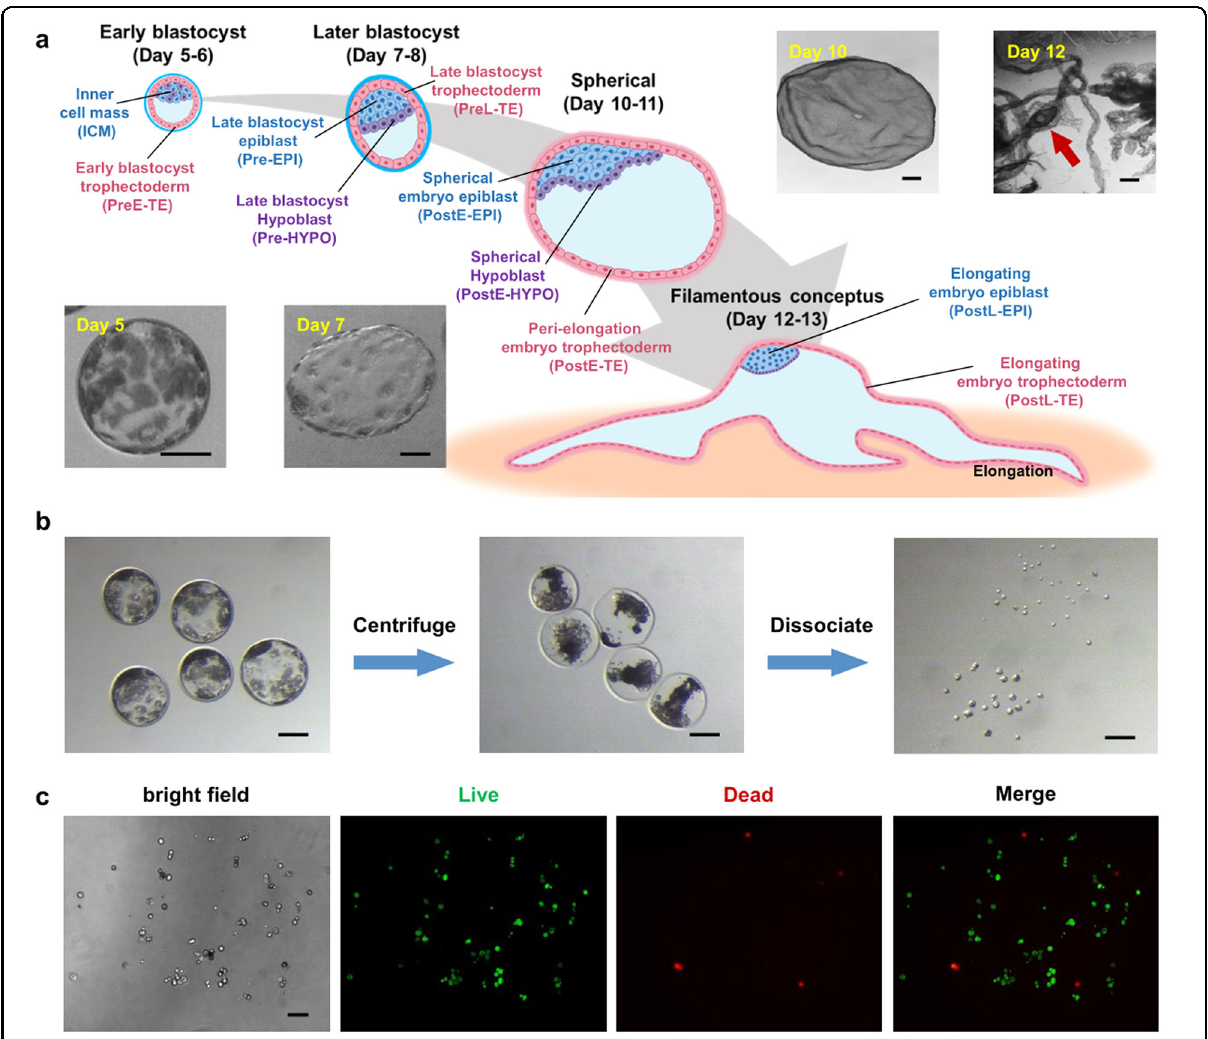
Fig. 1 Pig embryo collection and dissociation. a Pig embryos collected from four stages for scRNA-seq. b Centrifugation and dissociation of pre- implantation pig embryos. c Dissociated single cells stained with propidium iodide (PI, red) and 2 μ mol/L calcein acetoxymethylester (Calcein-AM, green). Scale bar represents 100 μ